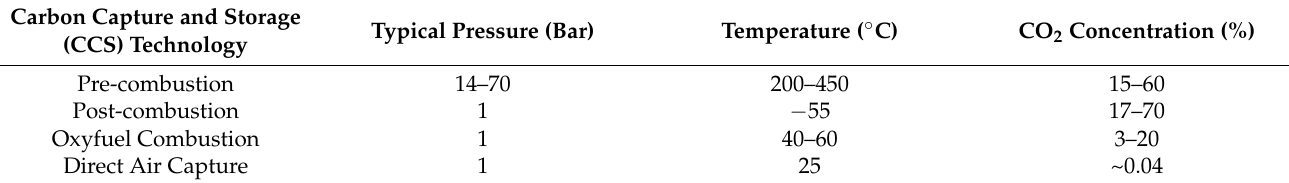
Table 1. Typical carbon capture and storage (CCS) technology